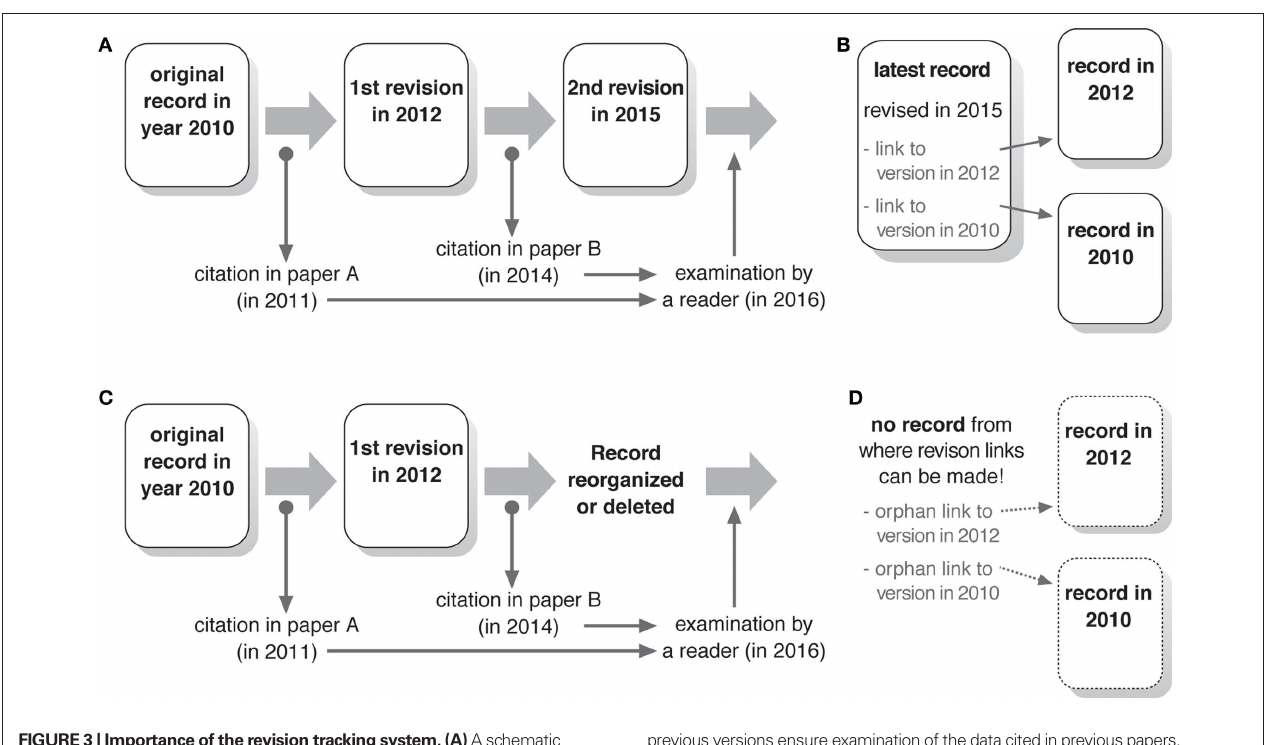
FigurE 3 | importance of the revision tracking system. (a) A schematic example of the citation of the database at different periods. Two papers refer to the same database record at different periods before and after revision. This may cause inconsistency between what are cited. If a reader of these papers examines the database at a later period, the person may not be able to get the same information cited in these papers. (b) Record with a revision tracking system. Links to